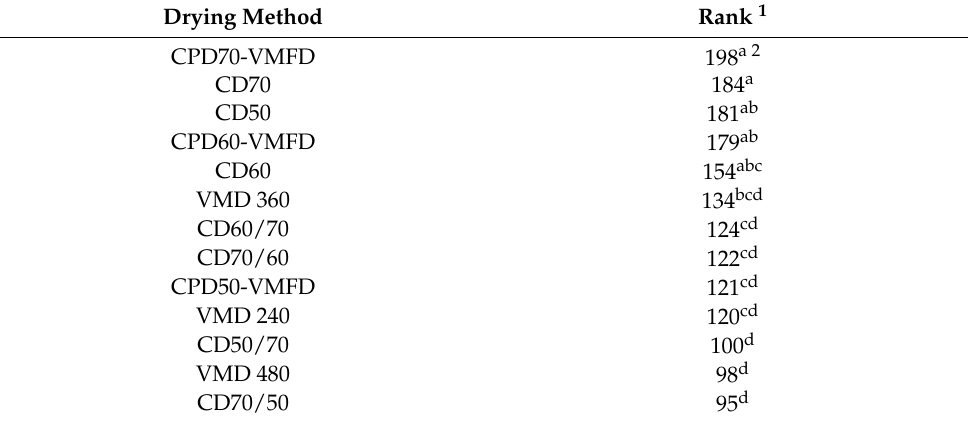
Table 5. Ranking test results—intensity of cilantro-like aroma of dried cilantro samples in comparison to fresh cilantro leaves. Drying Method Rank